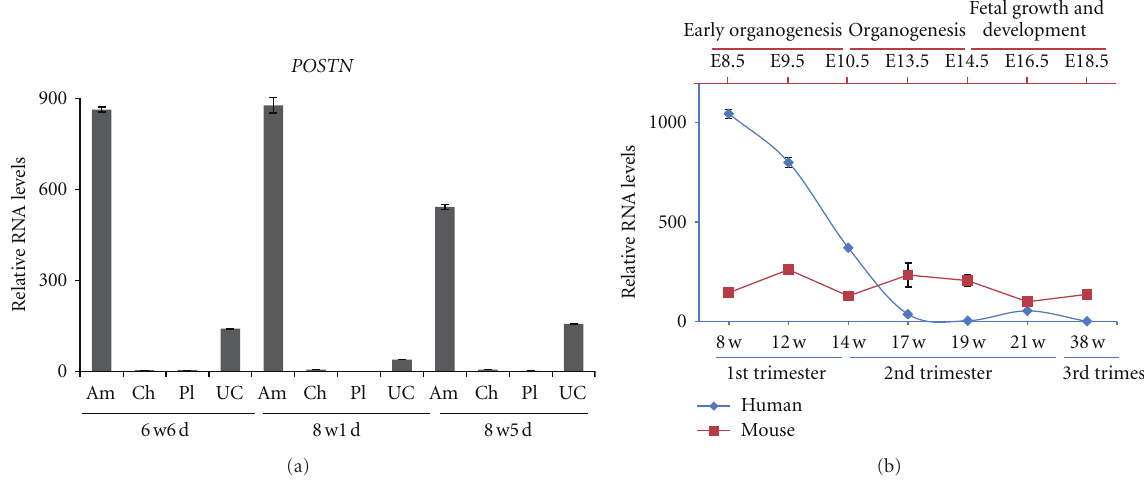
Figure 4: (a) RNA profiling of POSTN in human extraembryonic tissues of three individual embryos by RT-qPCR. Gestational age is represented by weeks (w) and days (d). (b) Relative RNA expression of Postn/POSTN in mouse and human amnion samples from di ff erent developmental stages. In human amnion POSTN is expressed at very high levels during the first trimester, followed by a significant drop in expression, whilst Postn expression in mouse amnion is stable during gestation. Mouse and human developmental stages are positioned along an arbitrary interval scale. Mouse and human gestation approximates 19.5 days and 38 weeks respectively. Mouse and human developmental stages do not match pairwise. Abbreviations: Am: amnion; Ch: chorion, E: embryonic day; Pl: placenta, UC: umbilical cord, 8–38 w: weeks of